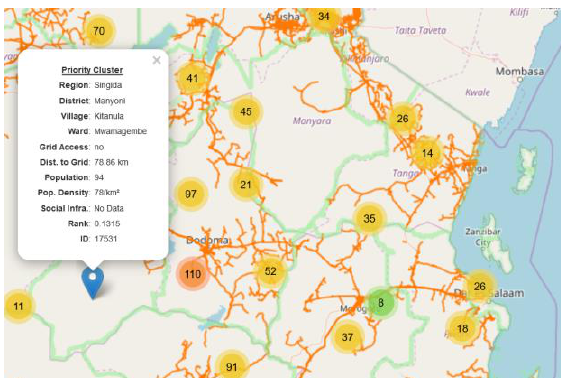
Figure 3. Screenshot of the interactive web-map, zoomed into eastern Tanzania and showcasing all village attributes of one village cluster in the